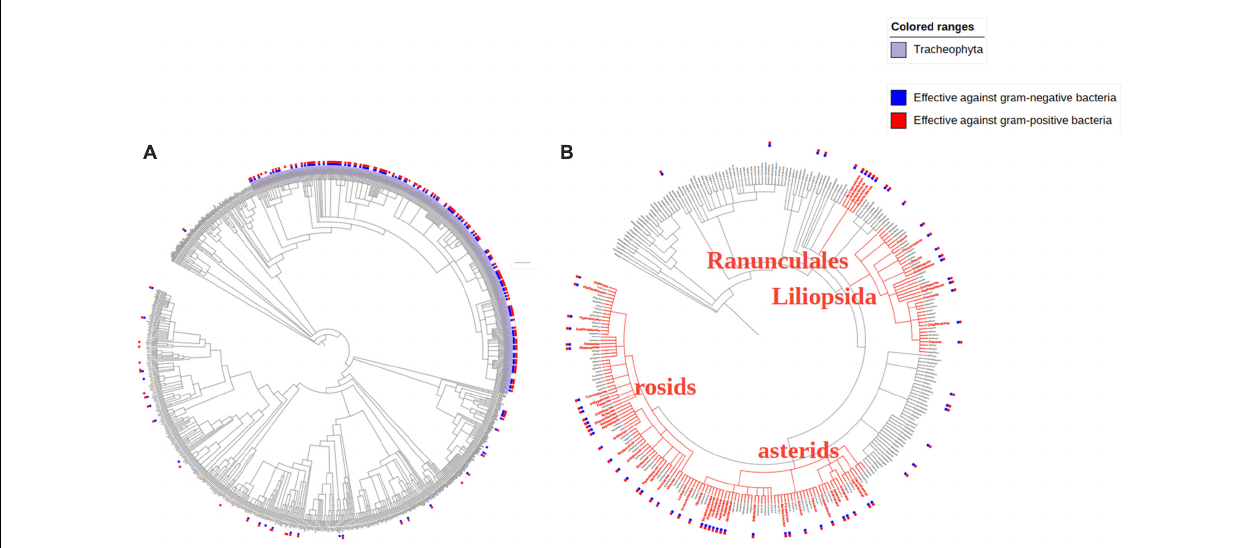
FIGURE 5 | Distribution of antibacterial TCMs original species on the phylogenetic tree (A) and Distribution of antibacterial TCMs in phylogenetic tree of Viridiplantae kingdom (B)